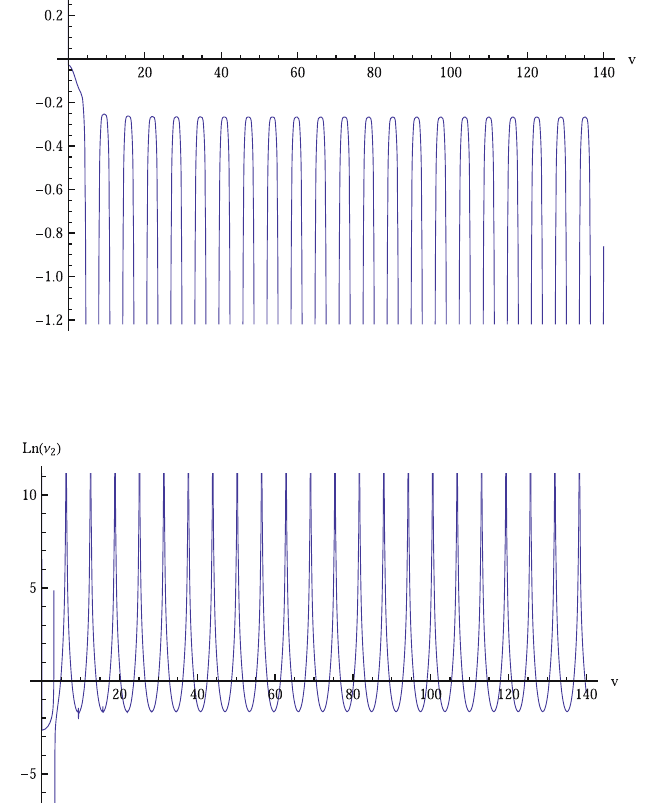
Figure 1: Behavior of ν 0 .